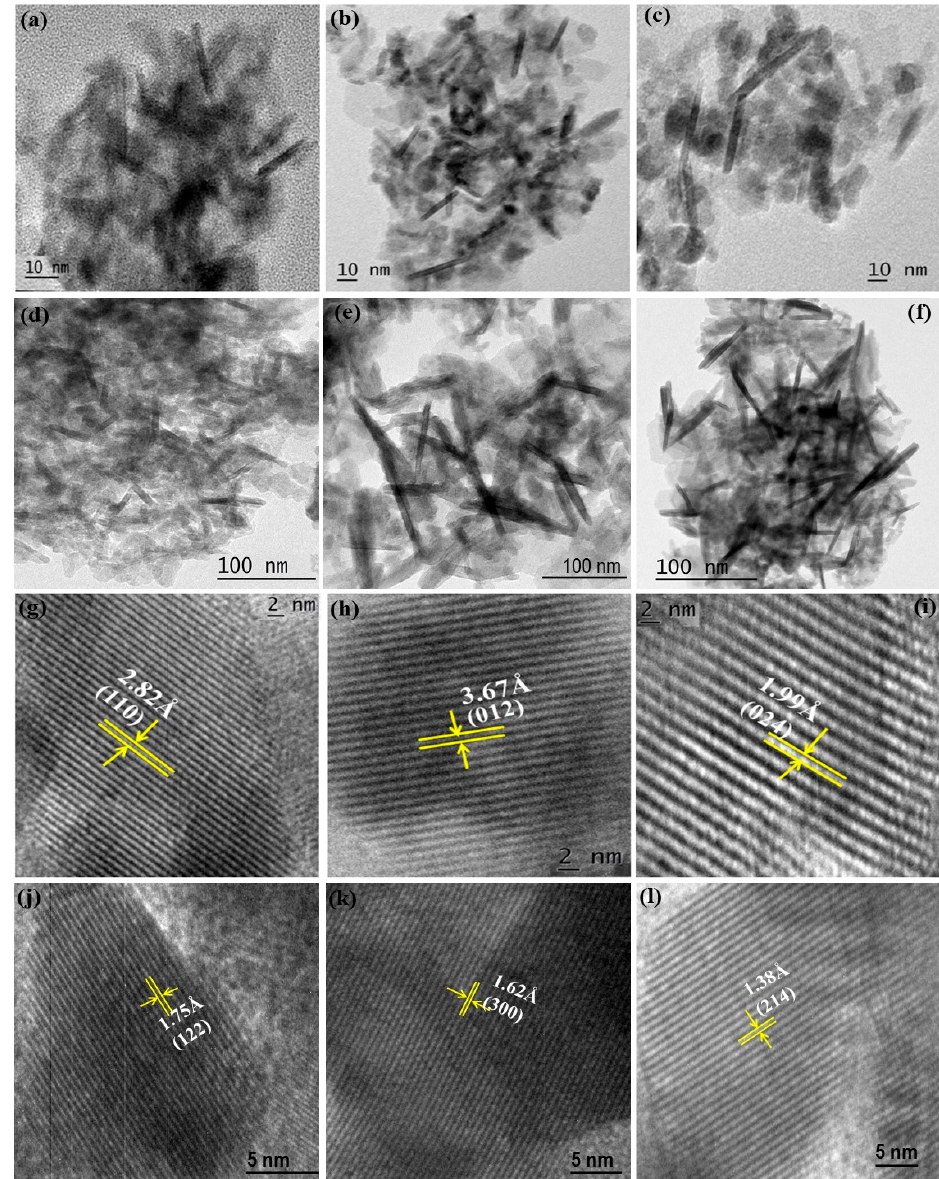
Figure 1. ( a – f ) HR-TEM images, ( g – l ) lattice fringes for the Bi 0.95 Ce 0.05 FeO 3 , Bi 0.90 Ce 0.10 FeO 3 , Bi 0.85 Ce 0.15 FeO 3 , Bi 0.95 Tb 0.05 FeO 3 , Bi 0.90 Tb 0.10 FeO 3 , Bi 0.85 Tb 0.15 FeO 3 nanostructures.